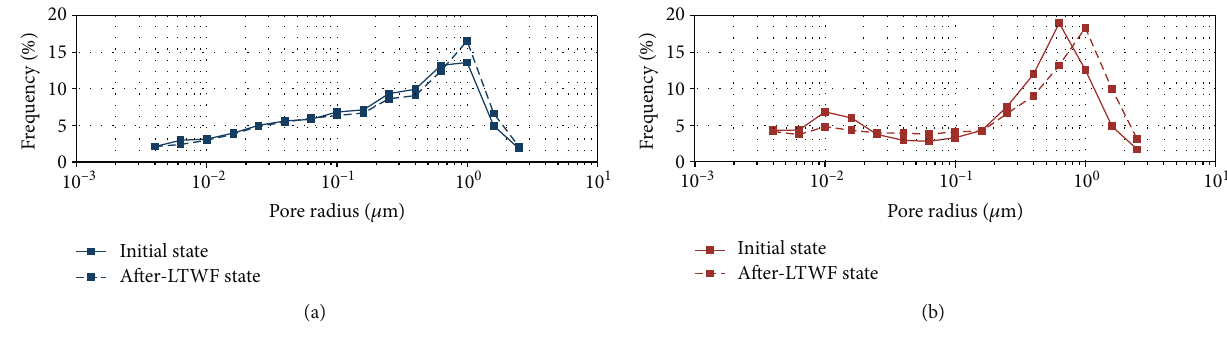
Figure 7: Comparison of the HPMIP curves between the initial state and after-LTWF state: (a) C9 and (b) C11. Table 5: Comparison of characteristic parameters between the initial state and after-LTWF state.